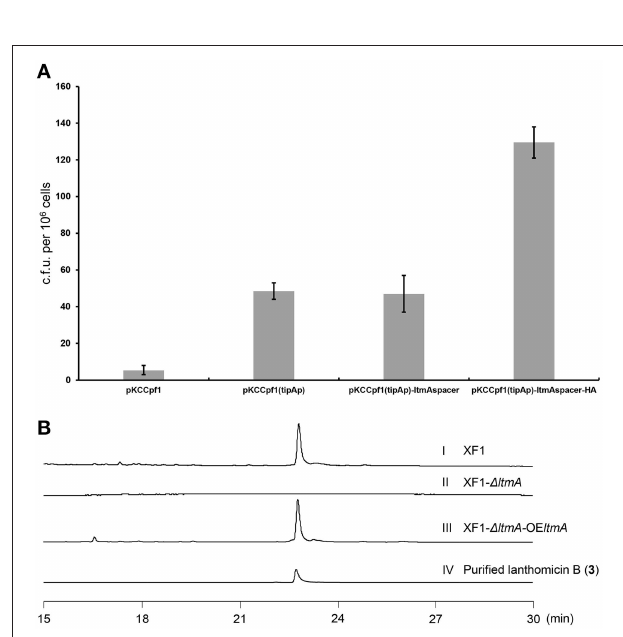
FIGURE 4 | Confirmation of lanthomicins biosynthesis gene cluster ltm by the CRISPR-Cpf1-based gene-editing system. (A) Transformation efficiency was evaluated by counting the transformant number per 10 6 viable spores. (B) HPLC analysis of lanthomicin B production from ltmA deletion and complement strains (UV at 480nm): (I) S. chattanoogensis XF1; (II) S. chattanoogensis XF1- 1 A; (III) S. chattanoogensis XF1- 1 A-OE-A; and (IV) isolated lanthomicin